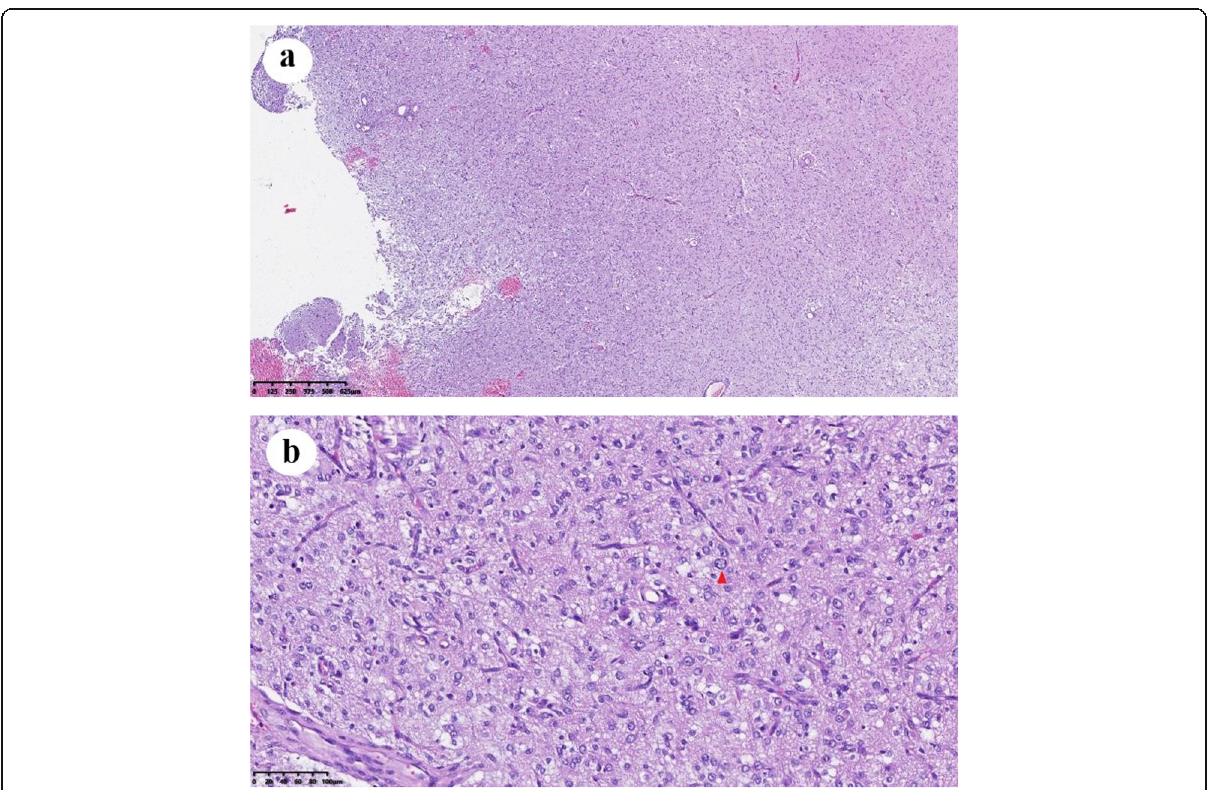
Fig. 5 Pathological examination revealed features of ganglioglioma. a Proliferative neuronal and glial cell elements arranged with abnormal architecture, with prominent capillary network (H&E staining, × 40), b Dysplastic neurons (arrow, H&E staining, ×